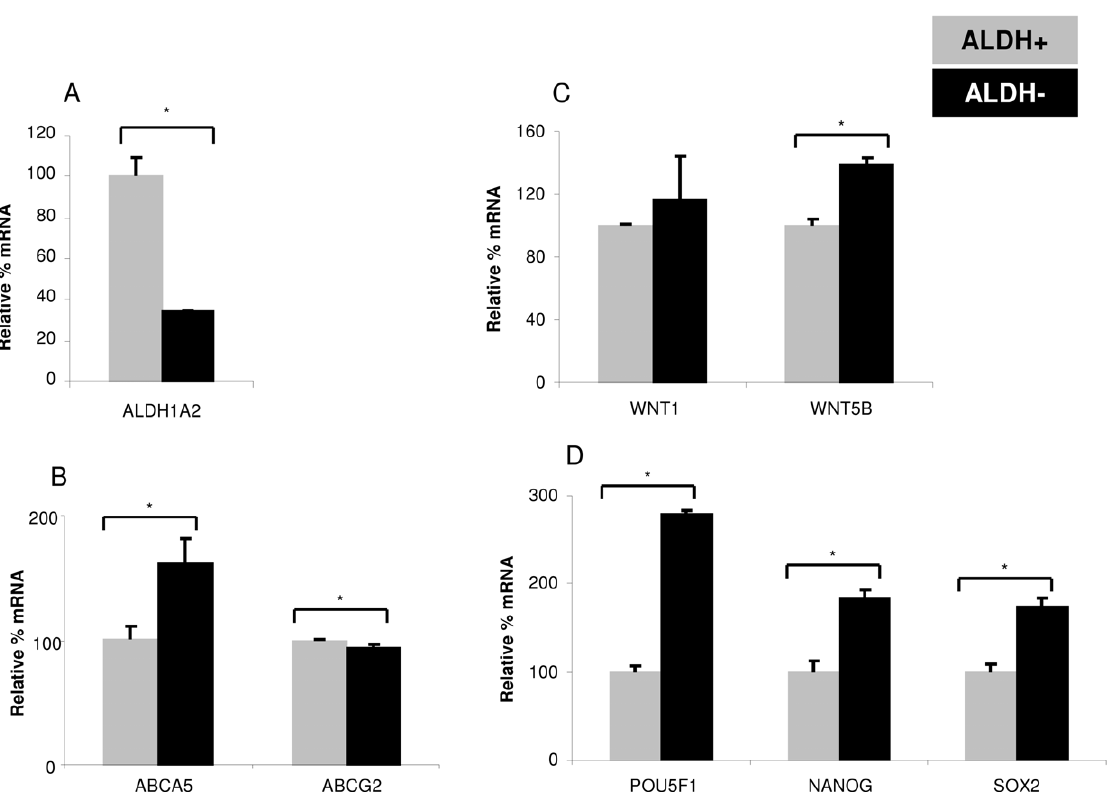
Figure 7. Differential transcript profile of ALDH + and ALDH 2 subpopulations sorted from CHA59 spheres. (A–D) ALDH + / 2 cells were sorted from CHA59 spheres using ALDEFLUOR staining and FACS. Subsequently, expression of various genes was measured in the sorted population by real-time RT-PCR analysis. *p , 0.05.